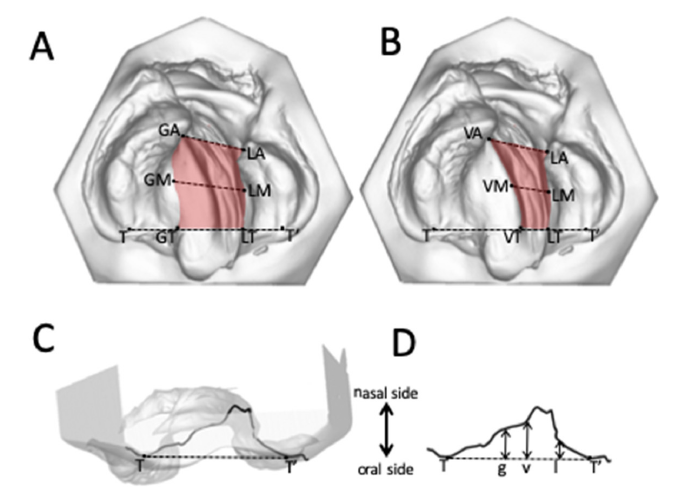
Figure 2. ( A ) Palatal cleft: palatal cleft width (dashed lines) and palatal cleft area (shaded area). ( B ) True cleft: true cleft width (dashed lines) and true cleft area (shaded area). ( C ) and ( D ) The height of the palate to the horizontal plane at the vomer edge (v) and at the greater (g) and lesser (l) palatal shelf ridges. Connecting corresponding equidistant points from g to l and v to l (0% and 0%, 12.5% and 12.5%, and so forth) led to 8 equidistant quadrangles, which were split into two triangles each, leading to a total of 16 triangles (Figure 3). Surface measurements of defined areas were then approximated as the sum of its comprising triangles.